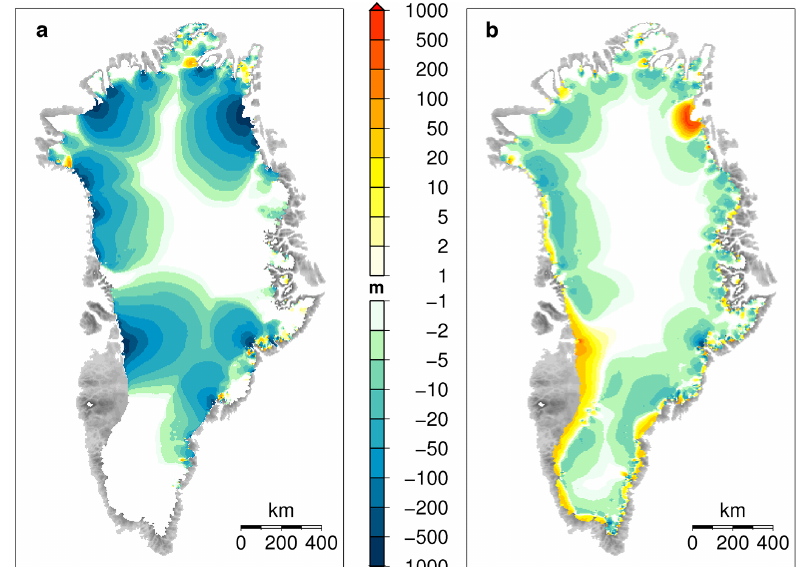
Figure 10. Ice thickness changes from ocean warming-induced discharge increase (a) and runoff-induced lubrication (b) . In this particular experiment, obtained with CanESM2 for RCP4.5, additional oceanic forcing accounts for 7.4cm of the total sea-level contribution of 32.0cm. The effect of basal lubrication increases mass loss by 0.1cm. This small extra contribution results from a general ice displacement expressed by relative thinning of the upper ablation area and resulting thickening of the marine margin (as shown in Shannon et al., 2013).